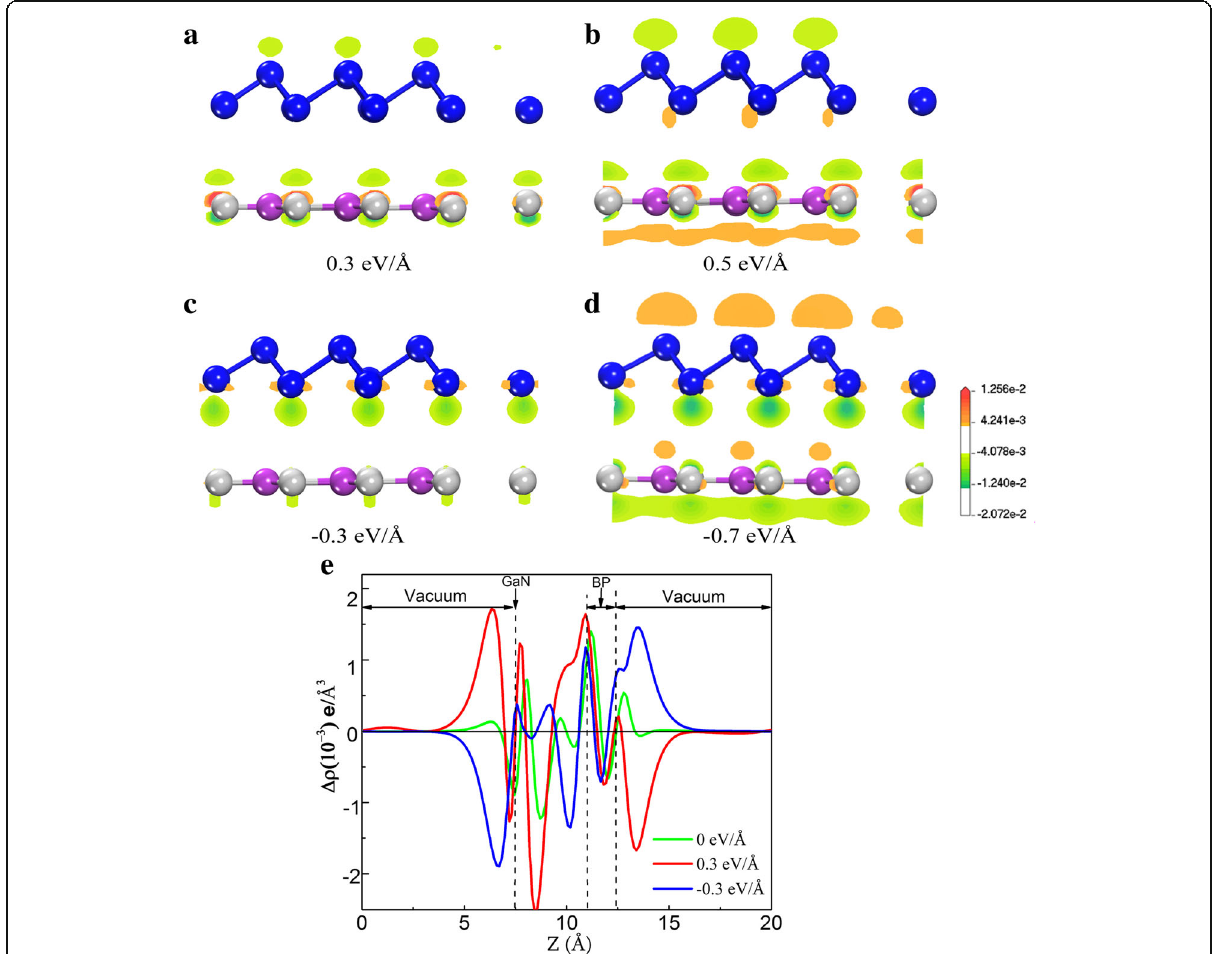
Fig. 4 a – d Isosurface of charge accumulation and depletion of monolayer-blueP/g-GaN heterostructure under E ext of 0.3 eV/Å, 0.5 eV/Å, − 0.3 eV/ Å, and − 0.7 eV/Å, respectively. Orange and light green isosurfaces represent positive charge accumulation and charge depletion, respectively. e Planar-averaged electron density Δρ ( z ) at different electrical field for